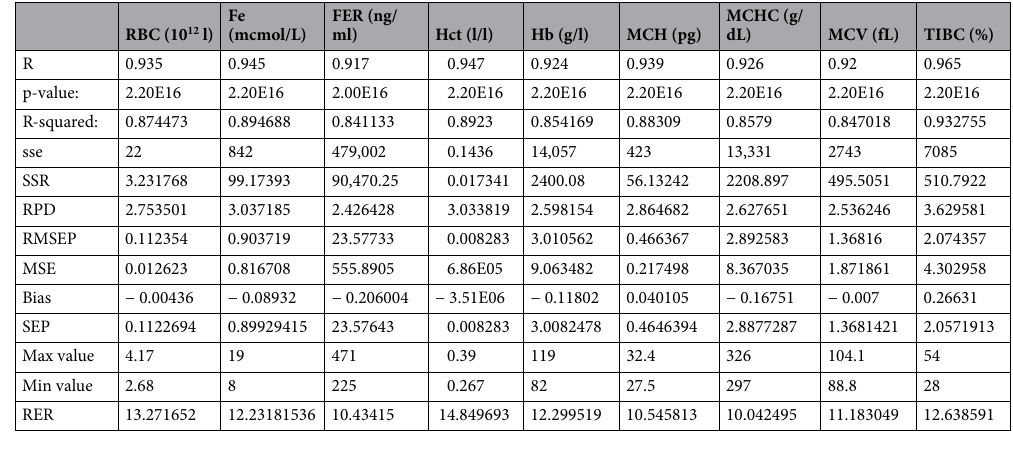
Table 2. Statistical parameters of the machine learning algorithm.